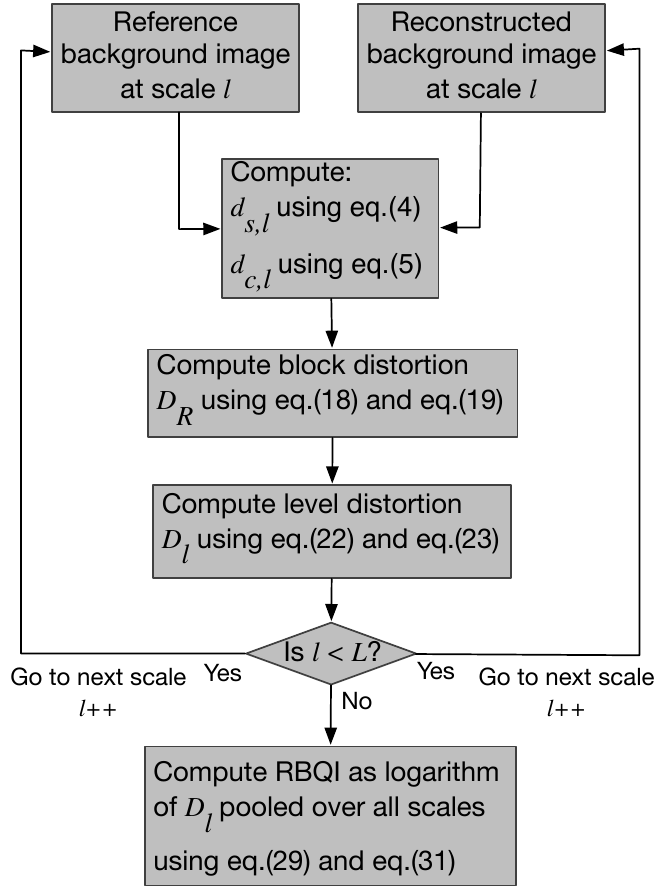
Figure 5. Block diagram describing the computation of the proposed Reconstructed Background Quality Index